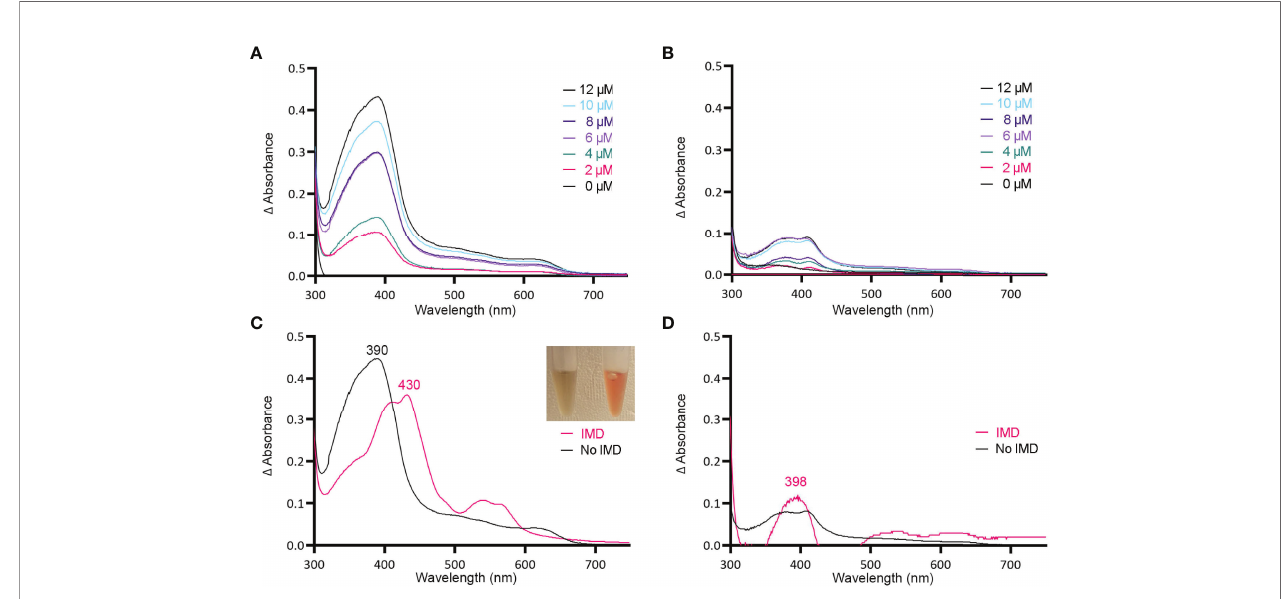
FIGURE 3 | MBP-HupZ binds heme b and uses exogenous histidine for iron coordination. UV-VIS absorption spectra of 10 m M MBP-HupZ (A) or MBP (B) incubated for 1 h with a range of heme concentrations. The blank contained the reaction buffer and equivalent concentration of heme. MBP-HupZ was incubated with 20 m M heme for 24 h, free heme was removed, and the UV-VIS spectrum was determined before ( C , black) or after the addition of 1.6 mM imidazole (IMD, pink). MBP (10 m M) was incubated with 20 m M heme for 24 h, free heme was removed, and the UV-VIS spectrum was determined before ( D , black) or after the addition of IMD